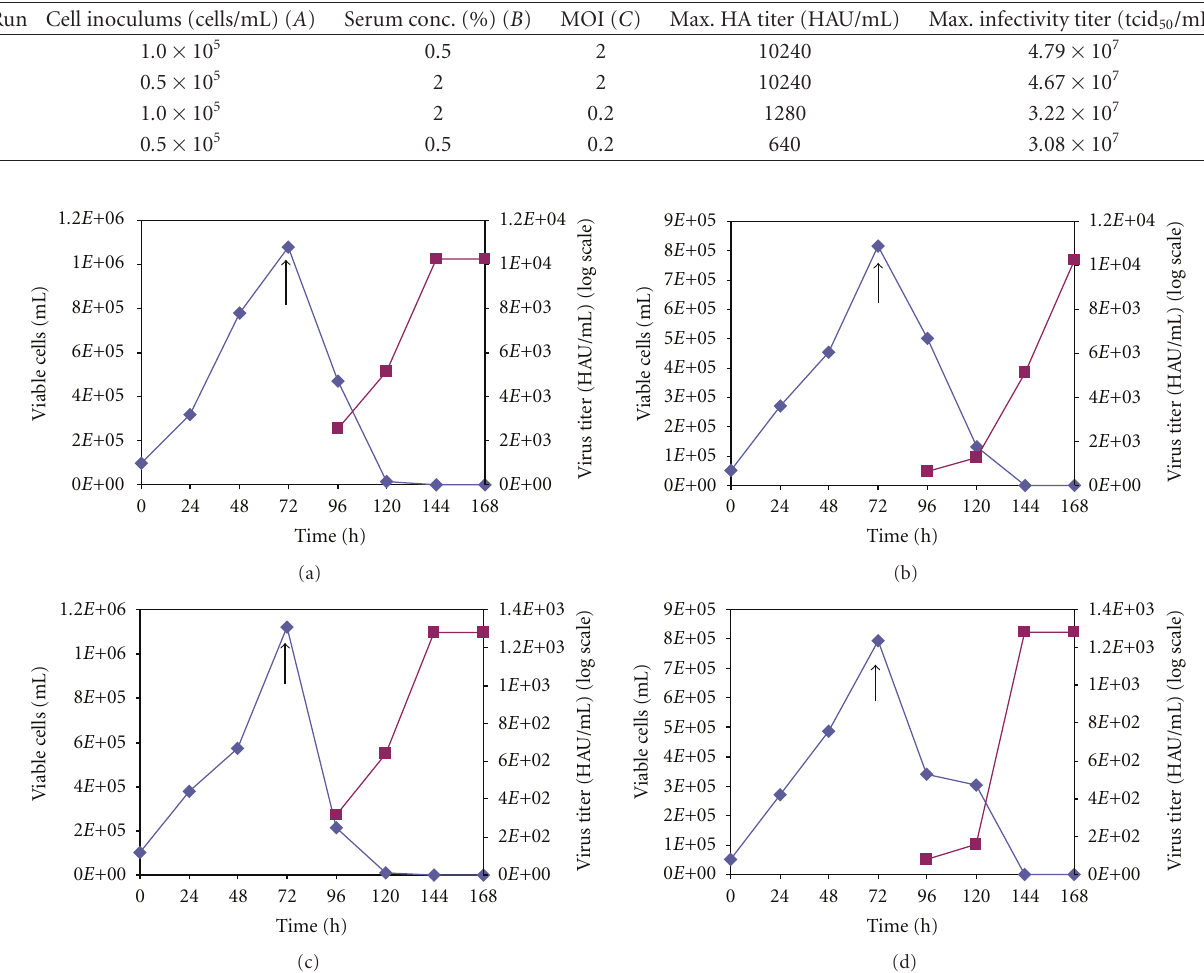
Figure 4: Growth of Vero cells on Cytodex 1 microcarrier and production of NDV: (a) cell inoculums: 1 . 0 × 10 5 cells/mL, serum concentration: 0.5%, MOI: 2.0; (b) cell inoculums: 0 . 5 × 10 5 cells/mL, serum concentration: 2.0%, MOI: 2.0; (c) cell inoculums: 1 . 0 × 10 5 cells/mL, serum concentration: 2.0%, MOI: 0.2; (d) cell inoculums: 0 . 5 × 10 5 cells/mL, serum concentration: 0.5%, MOI: 0.2. ( ↑ ) indicates cell